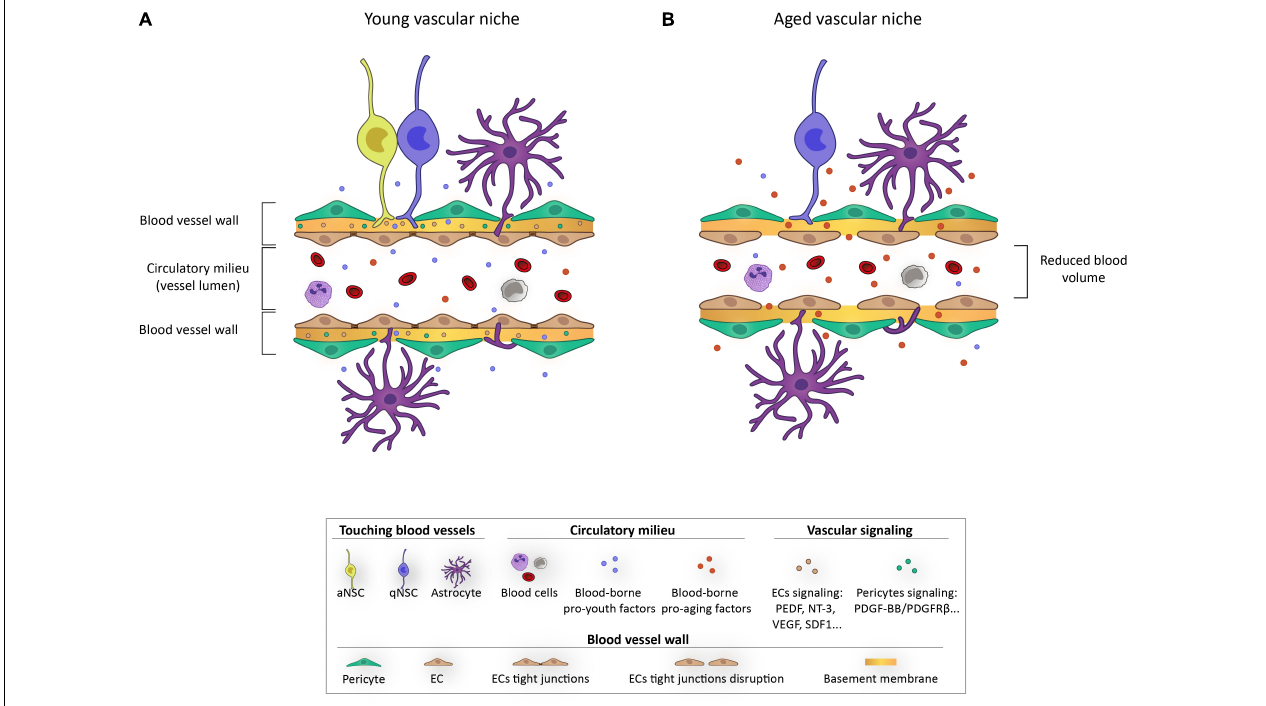
FIGURE 3 | Schematic representation depicting the impact of aging on the vascular